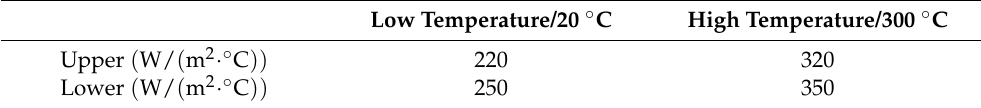
Table 5. The upper and lower boundaries of modified thermophysical parameters.